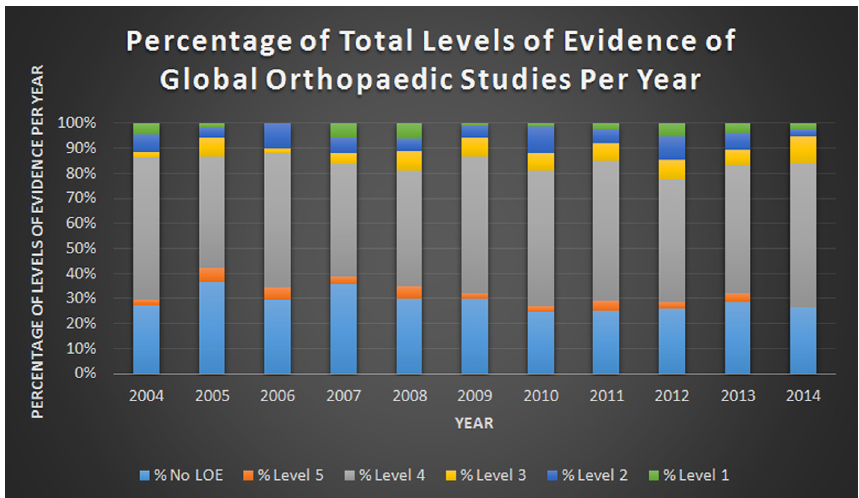
Figure 3. Percentage of total levels of evidence of global orthopaedic studies conducted in low- and middle-income countries per year from June 2004 June 2014.